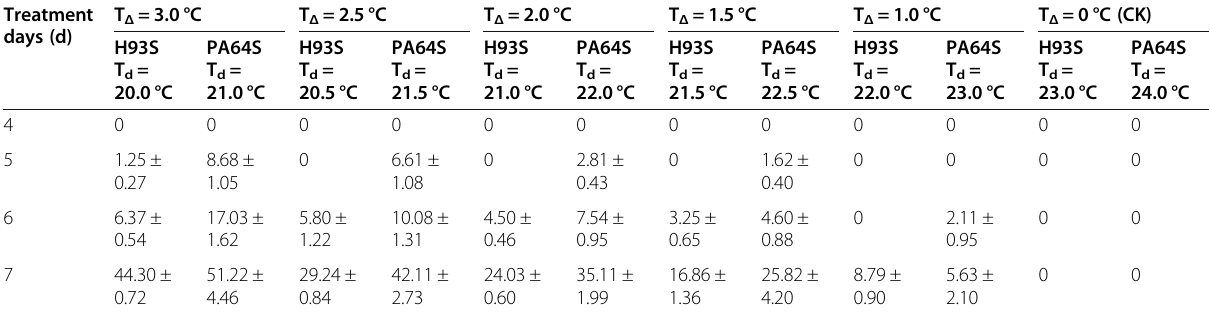
Table 4 PFPs (%) of H93S and PA64S with different treatment days and different T Δ values under a 13.5 h photoperiod Treatment days